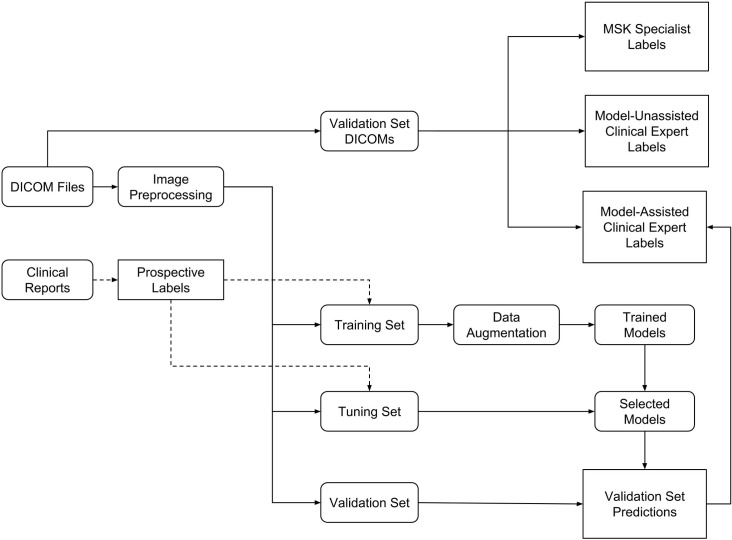
Experimental setup flowchart.We retrospectively collected a dataset of 1,370 knee MRI examinations used to develop the model and to assess the model and clinical experts. Labels were prospectively obtained through manual extraction from clinical reports. Images were extracted from DICOM files, preprocessed, then linked to reports. The dataset was split into a training set (to develop the model), a tuning set (to choose among models), and a validation set (to assess the best model and clinical experts). The validation set DICOMs correspond to the same exams as the validation set, but the images in the validation set were preprocessed before input to the model. These validation exams were independently annotated by musculoskeletal (MSK) radiologists (MSK specialists), model-unassisted clinical experts, and model-assisted clinical experts.